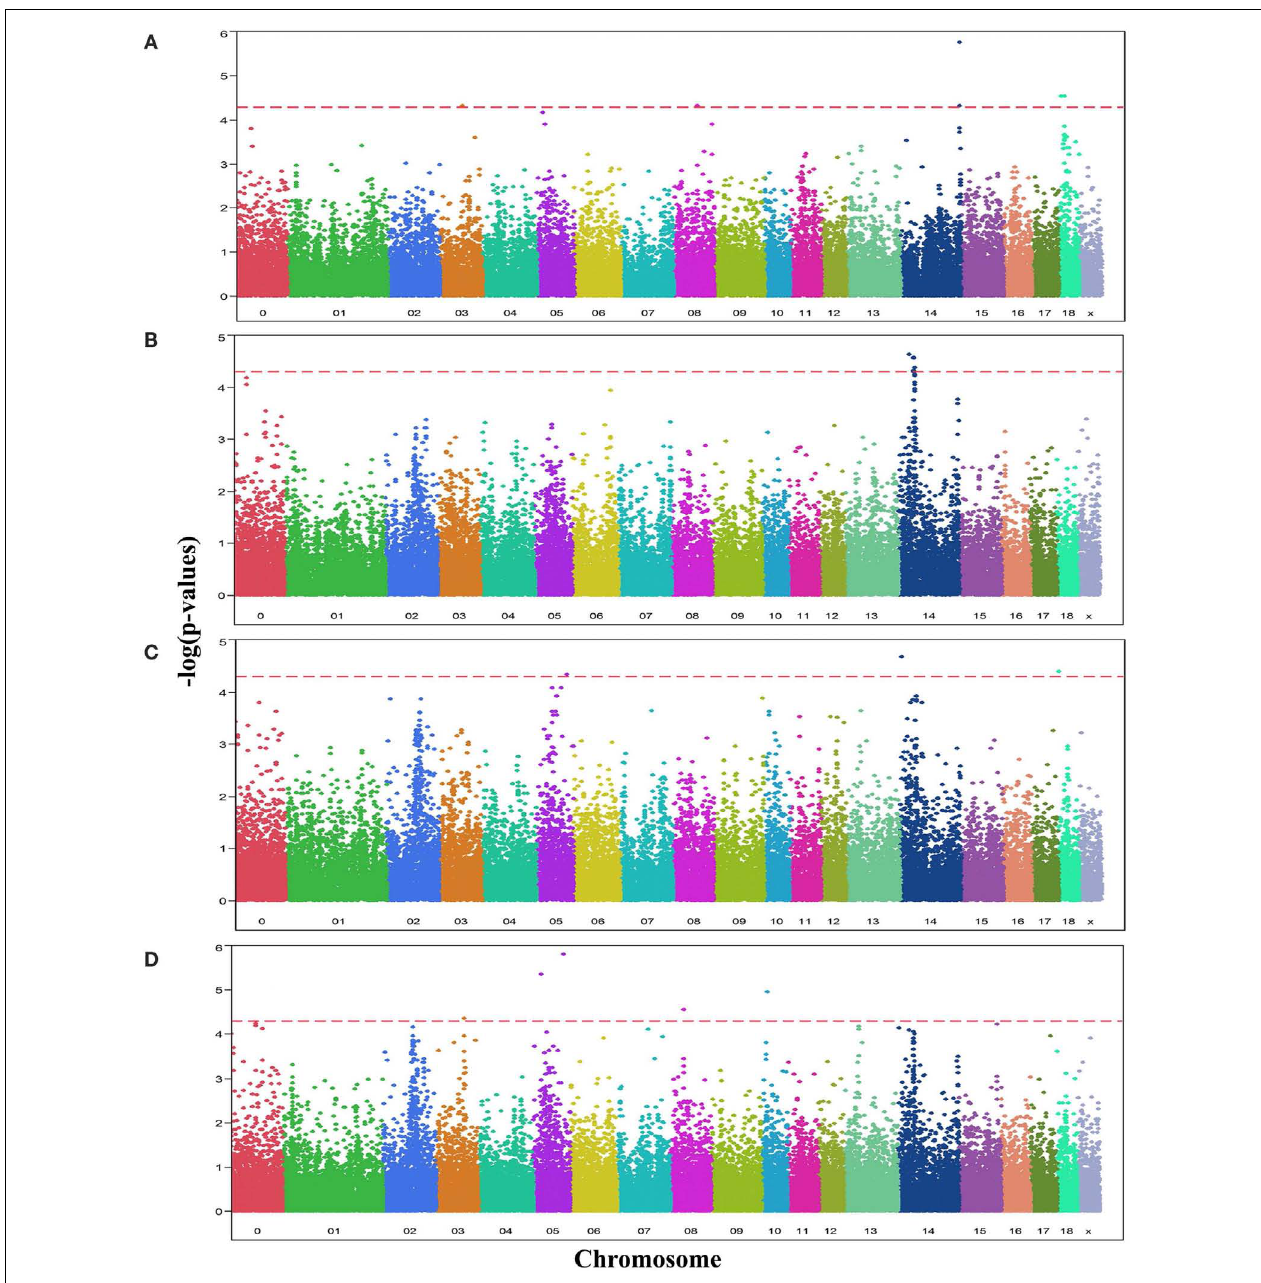
FIGURE 1 | Manhattan plots displaying the significance of associations of SNPs with OC lesion scores at (A) medial part of condylus humeri (CMH), (B) condylus medialis femoris (CMF), (C) distal epiphyseal cartilage of ulna (DEU), and (D) category of OC